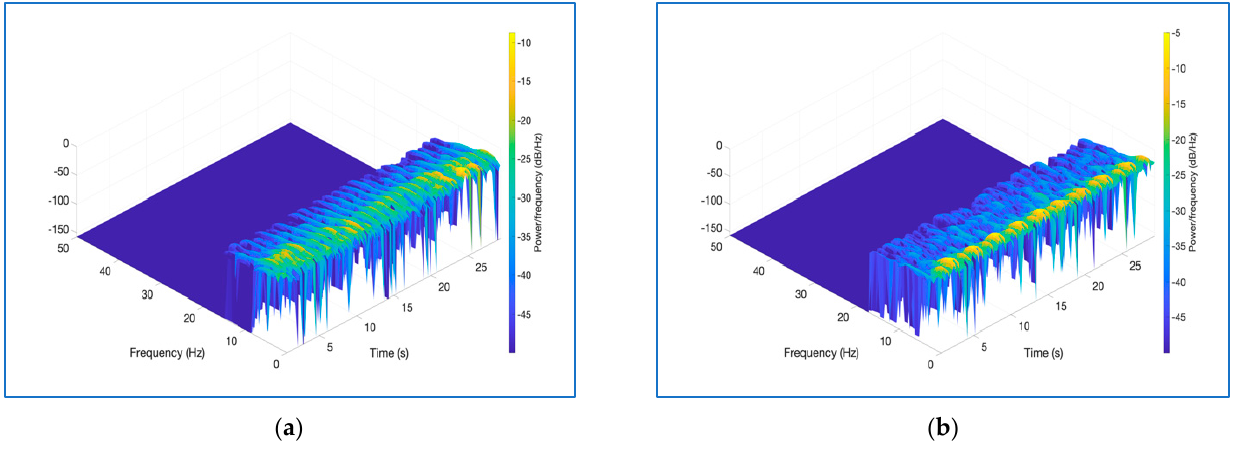
Figure 5. 3D spectrogram image of normotensive ( a ) and hypertensive ( b ) subjects in the dataset.